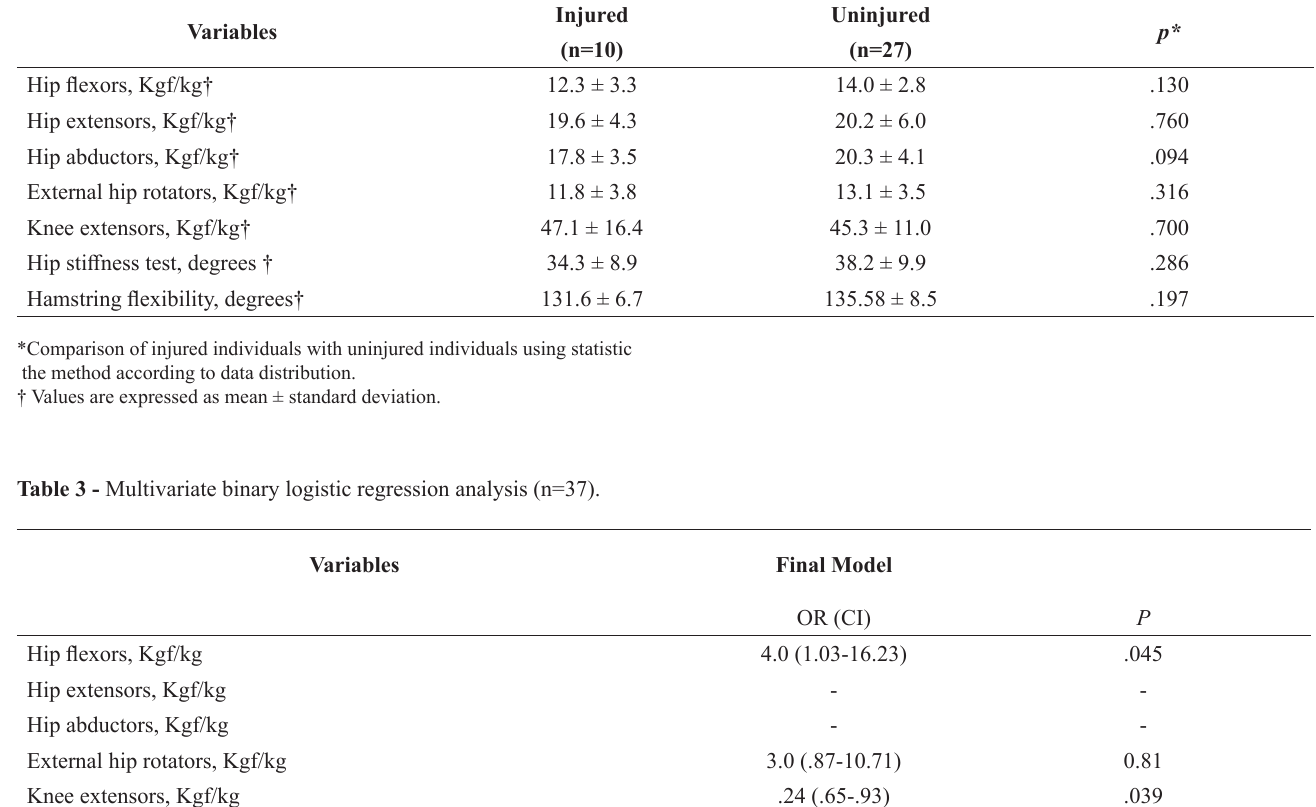
Table 2 - Tests assessed at baseline